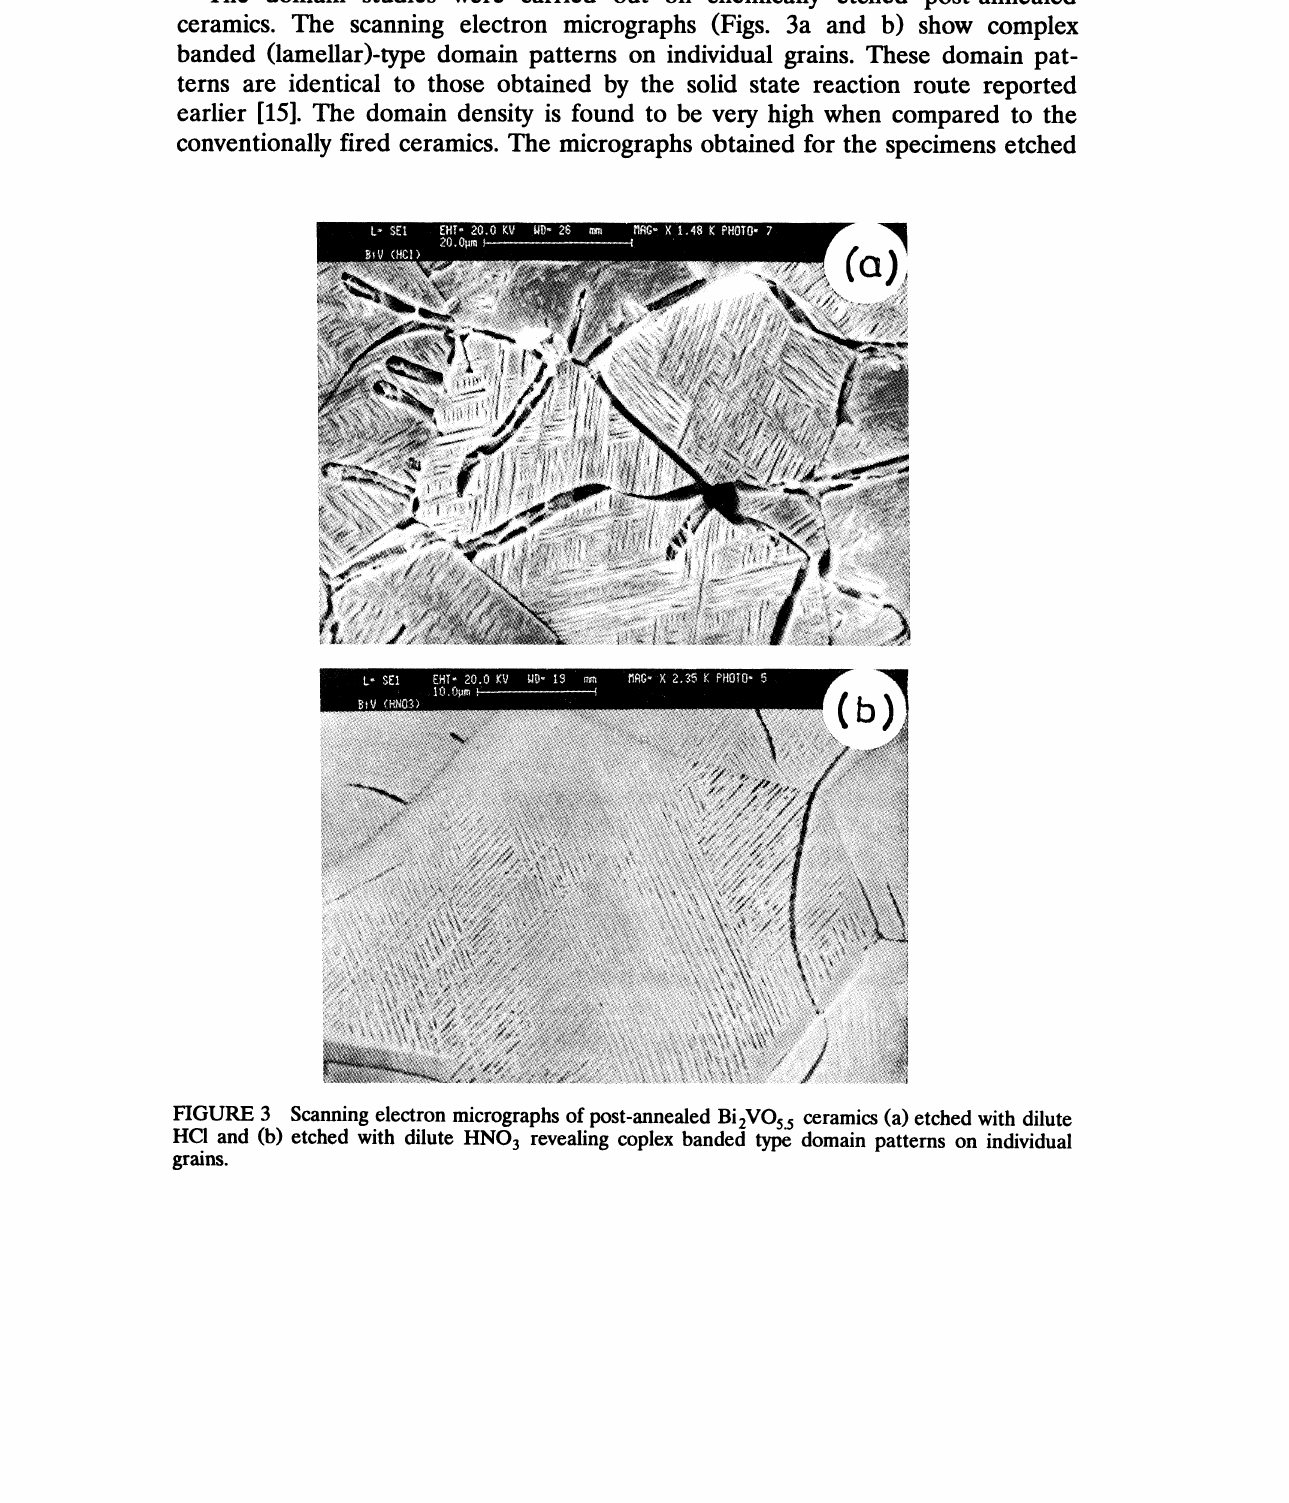
FIGURE 3 Scanning electron micrographs of post-annealed Bi2VOs.5 ceramics (a) etched with dilute HCI and (b) etched with dilute HNO revealing coplex banded type domain patterns on individual